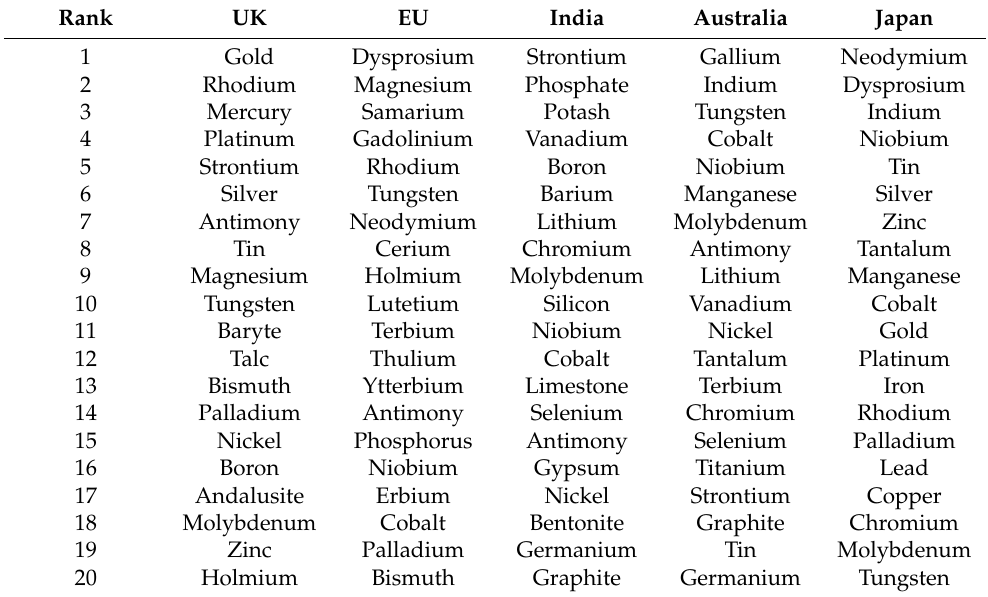
Table 3. Top 20 critical materials for the UK, the EU, India, Australia and Japan.